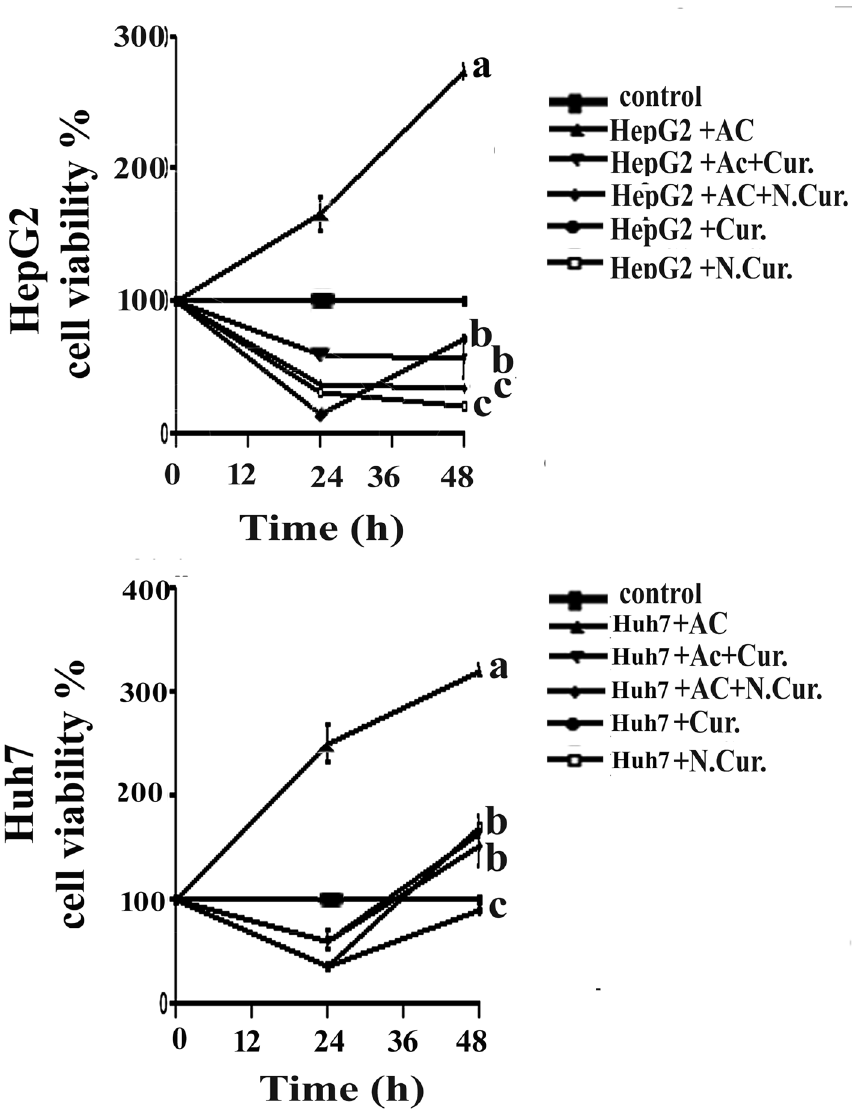
Figure 2. Curcumin and nanocurcumin reduced the viability of cultured HepG2 and Huh-7 hepatic cancer cells. Viability was measured by MTT assay. Data presented as mean ± SEM after 24 and 48 h of treatment. Values with unlike superscript letters are significantly